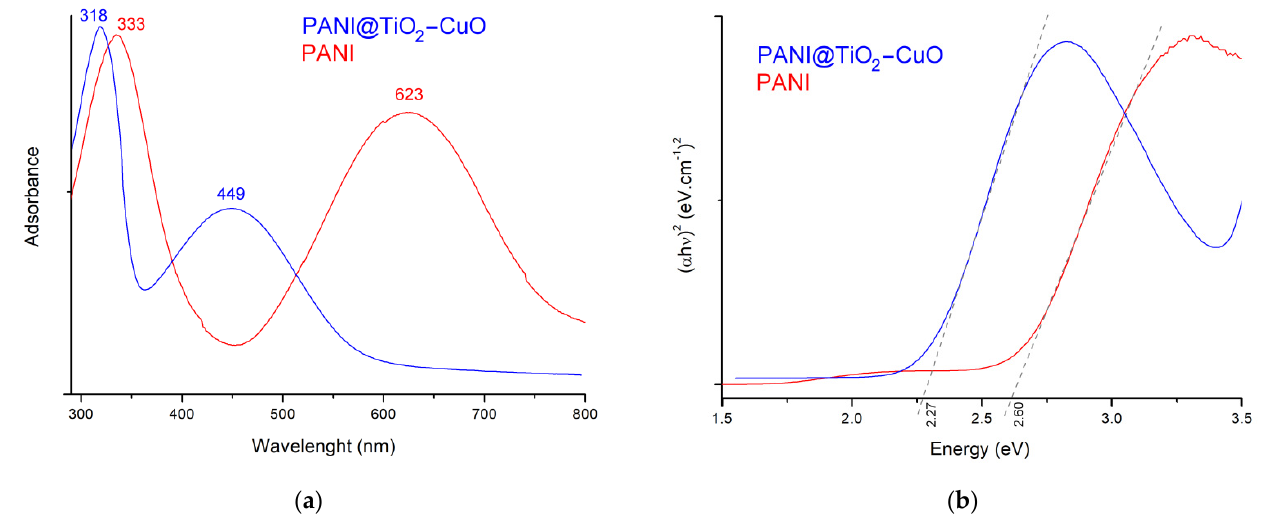
Figure 6. ( a ): UV-vis spectroscopy absorption spectra and ( b ): Tauc plots of samples.